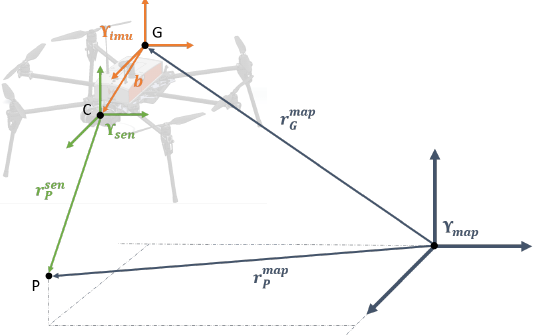
Figure 1. Principle of direct georeferencing - definition of reference